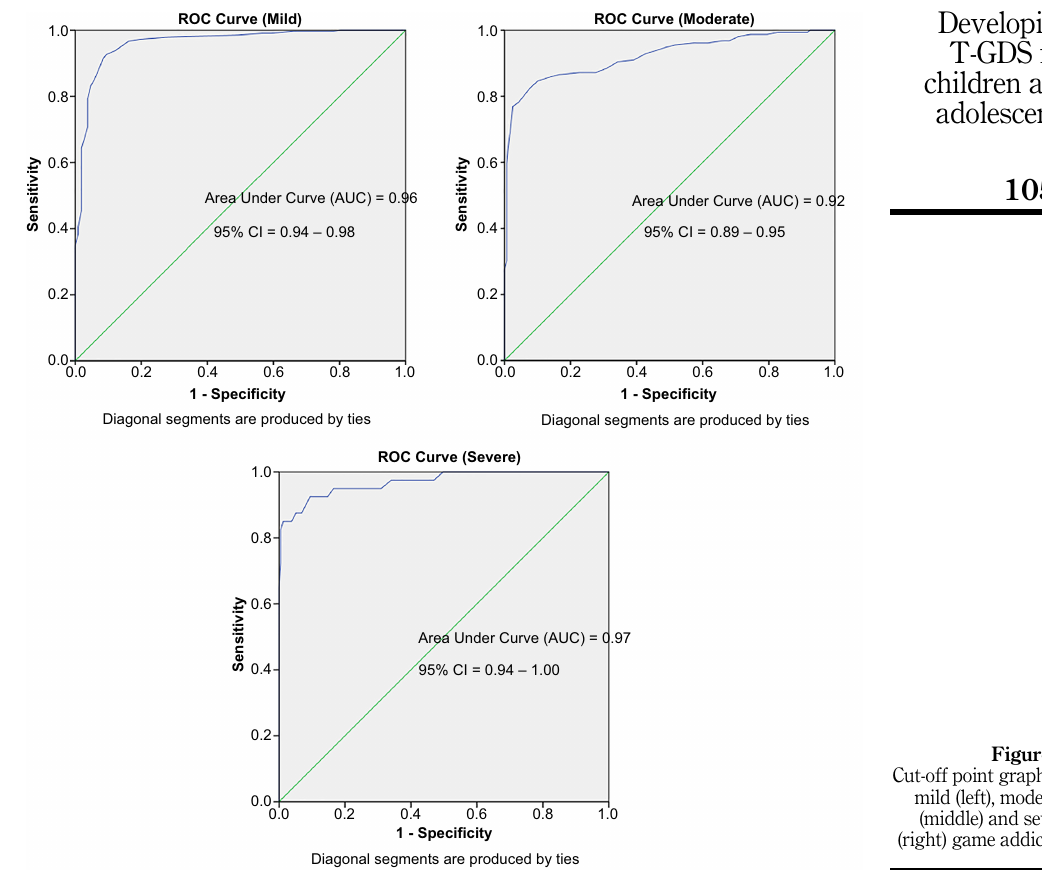
Figure 1. Cut-off point graph for mild (left), moderate (middle) and severe (right) game